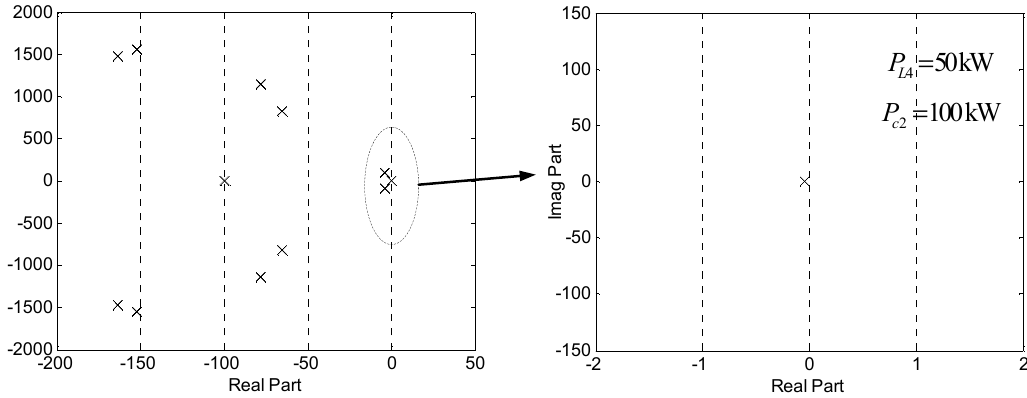
Figure 11. The dominant poles of